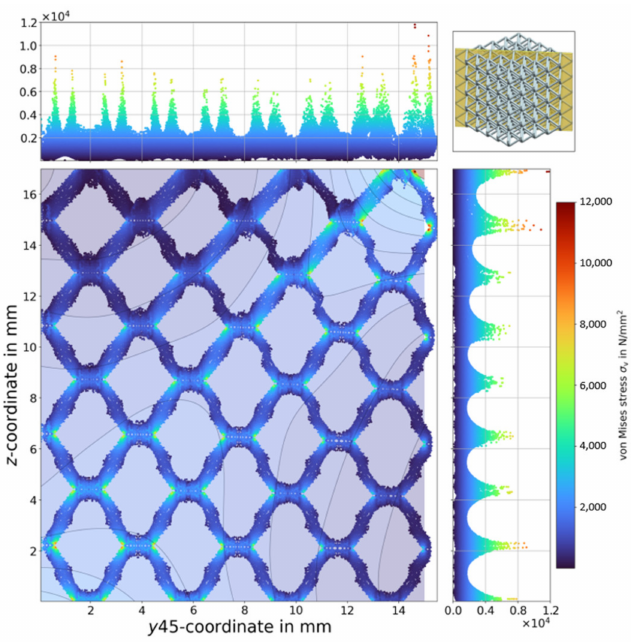
Figure 6. Sample without transition area—Von Mises stress of bcc 8 × 8 × 8—diagonal view